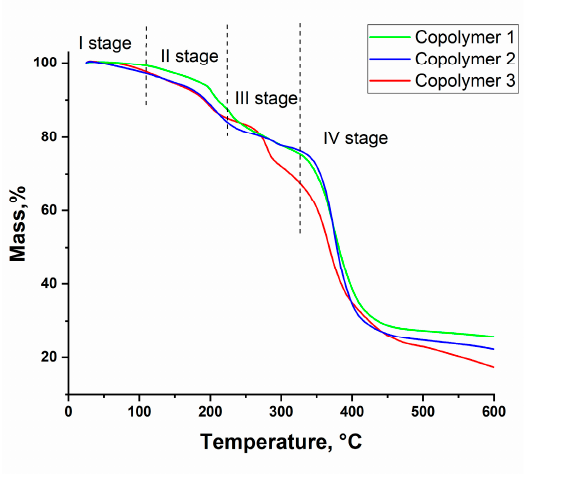
Table 3. Thermal properties of copolymers.